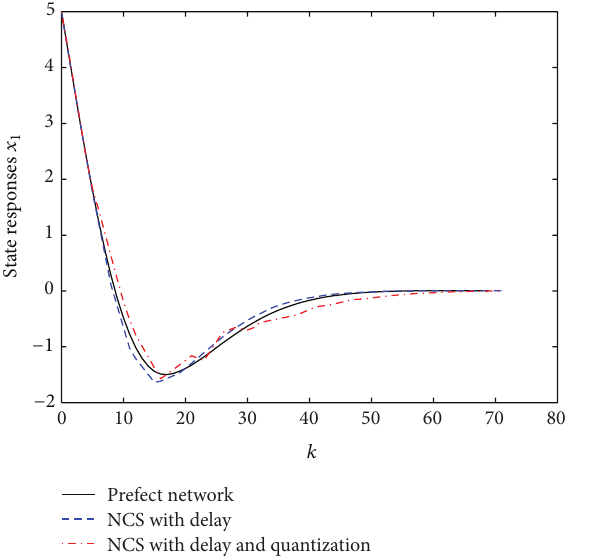
Figure 6: The state trajectory (Example 1).